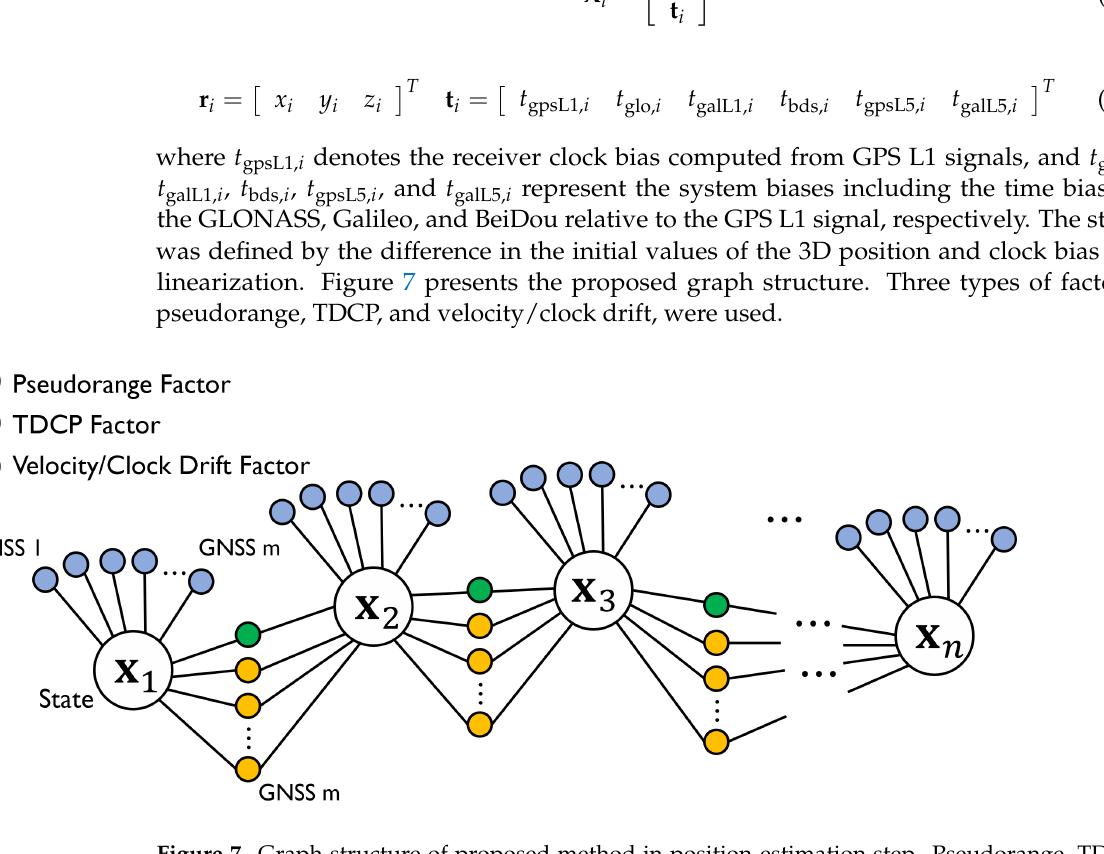
Figure 7. Graph structure of proposed method in position-estimation step. Pseudorange, TDCP, and velocity/clock drift factors were